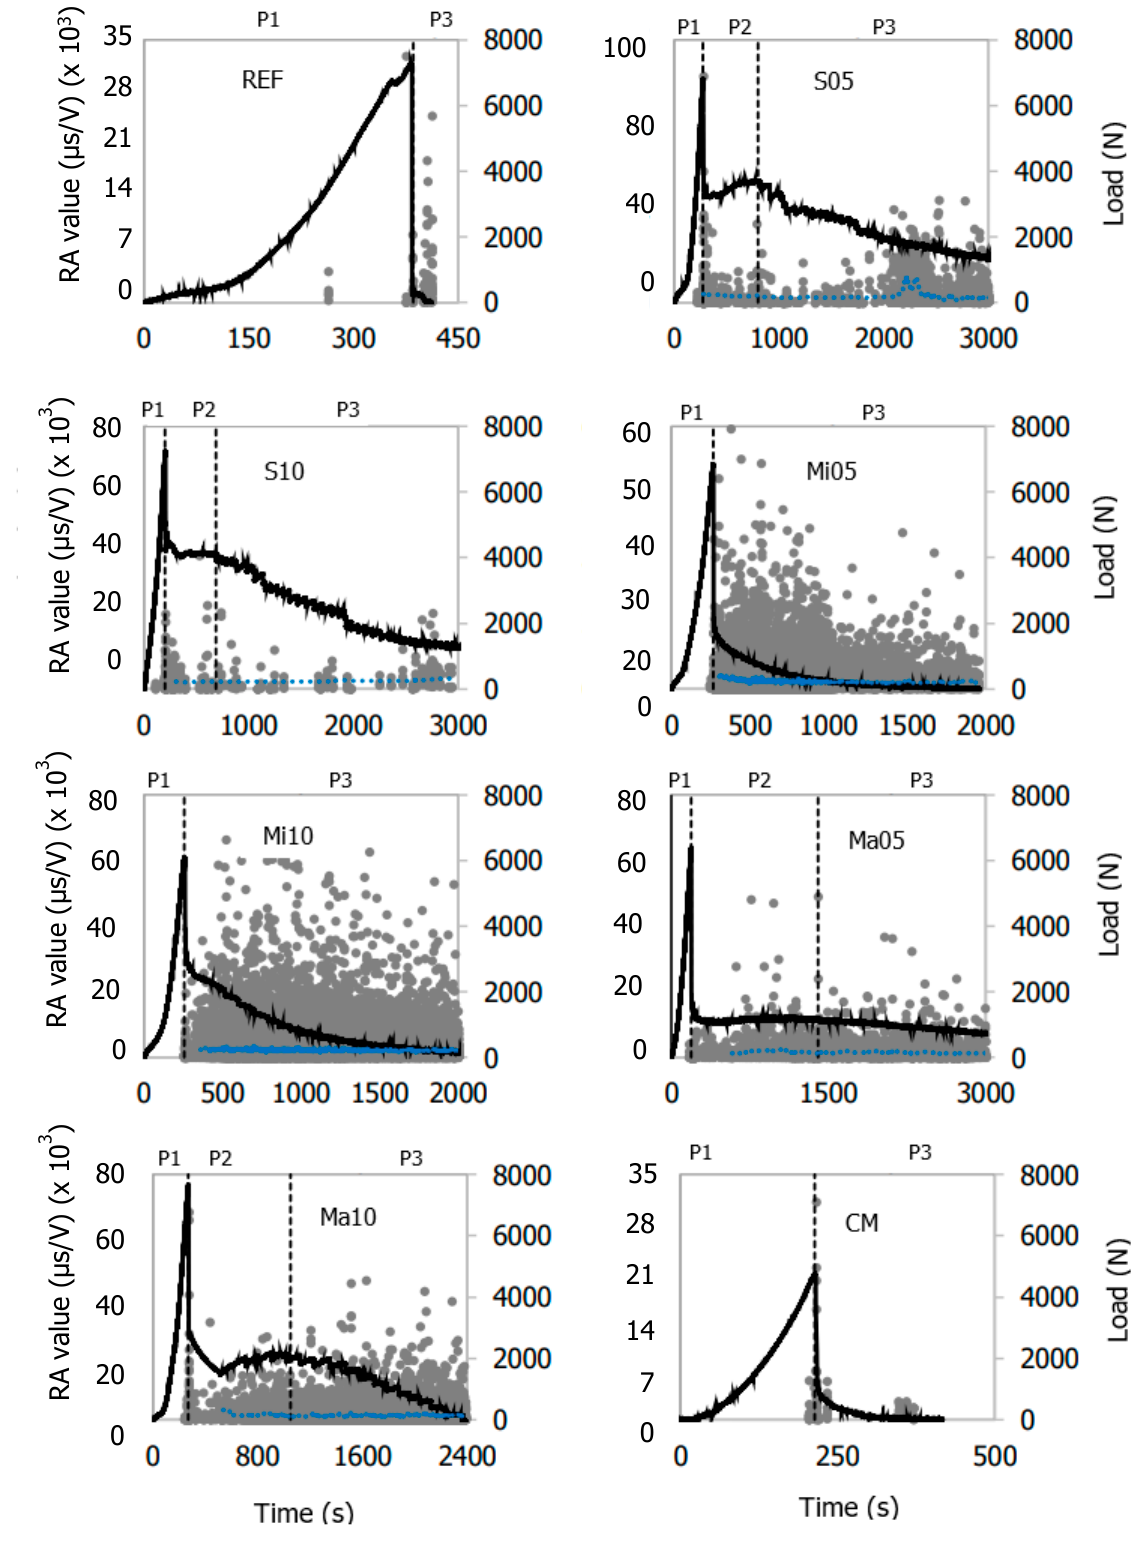
Figure 11. Raw RA value distributions of the AE activities ( ● Raw RA value, ● ● ● Moving average of raw RA value, ― Load).